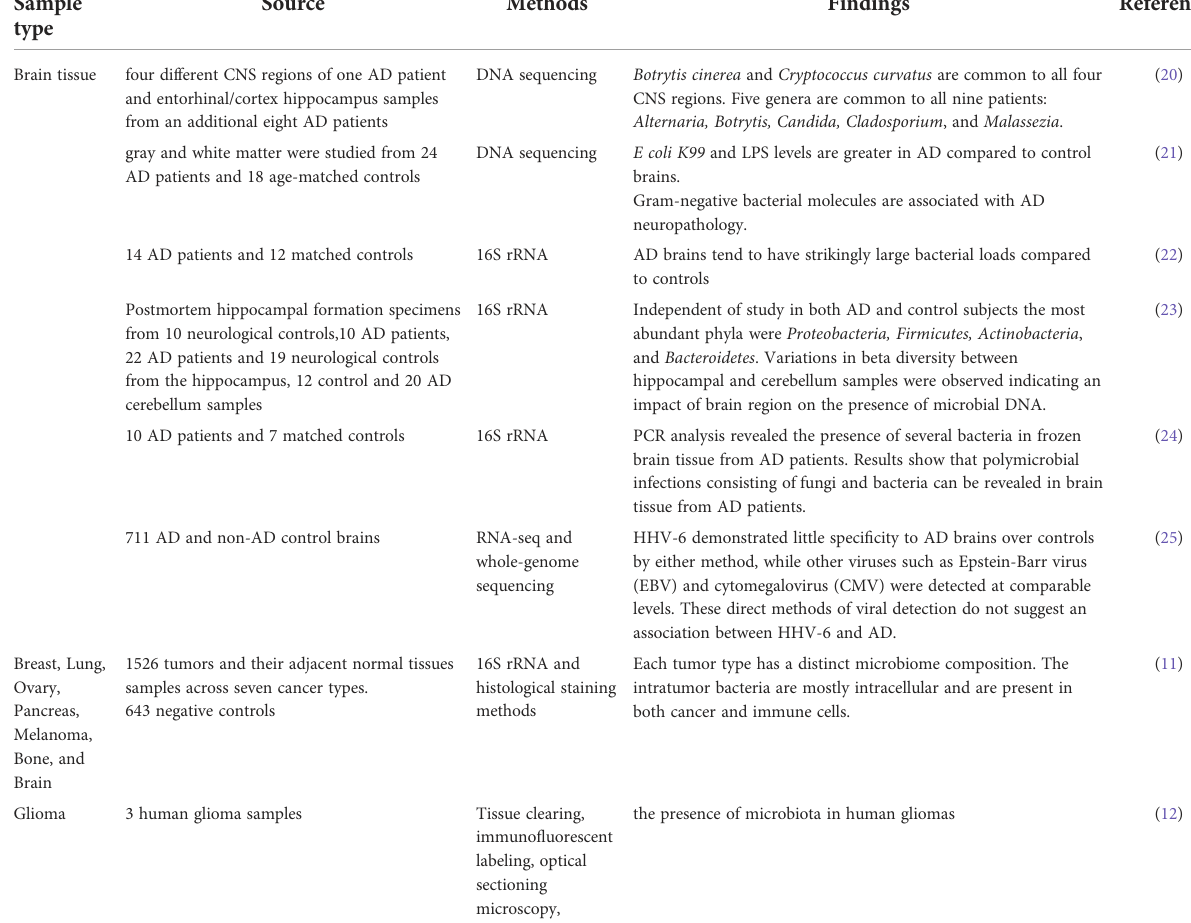
TABLE 1 Summary of recent fi ndings on brain tissue